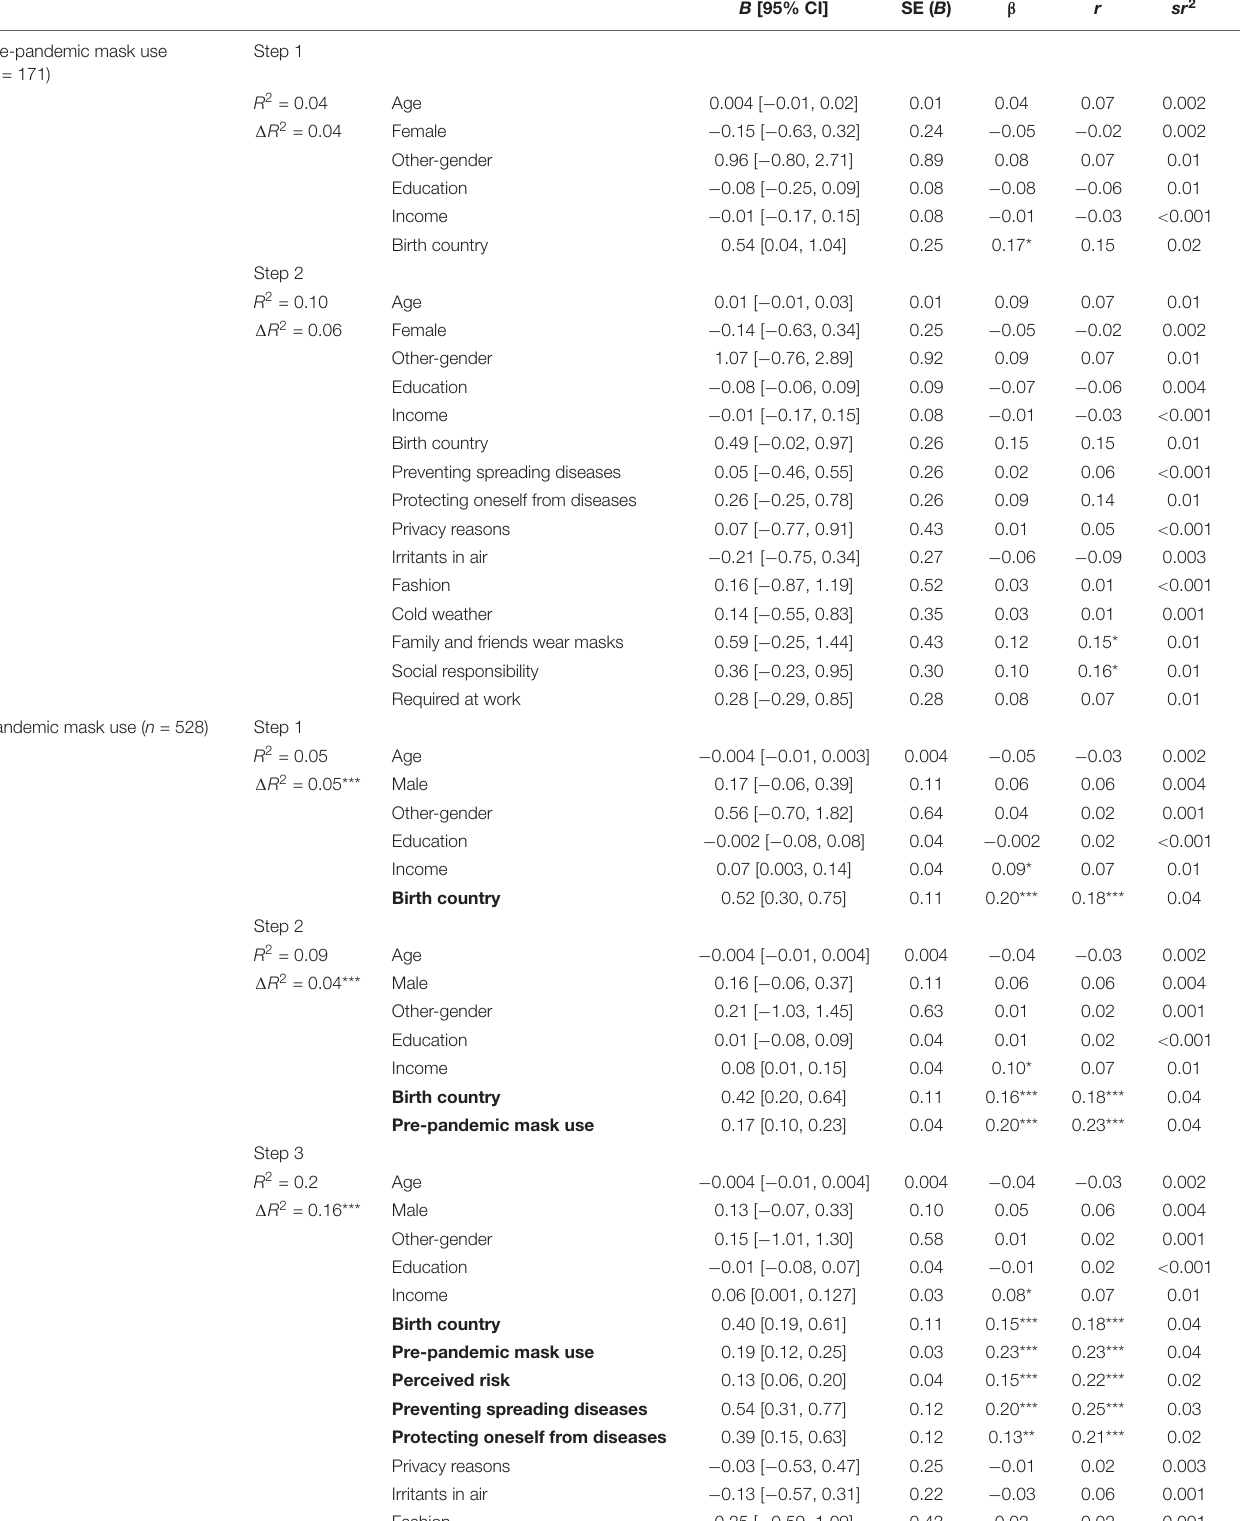
B [95% CI] SE ( B ) β r sr 2